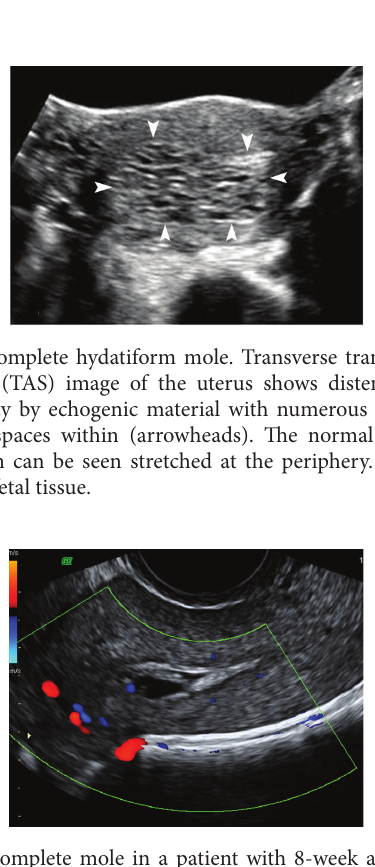
Figure 2: Complete mole in a patient with 8-week amenorrhoea resemblingablightedovum.Sagittaltransvaginalsonography(TVS) shows an anechoic empty gestational sac-like structure with thin echogenic lining and a size smaller than expected for the gestational